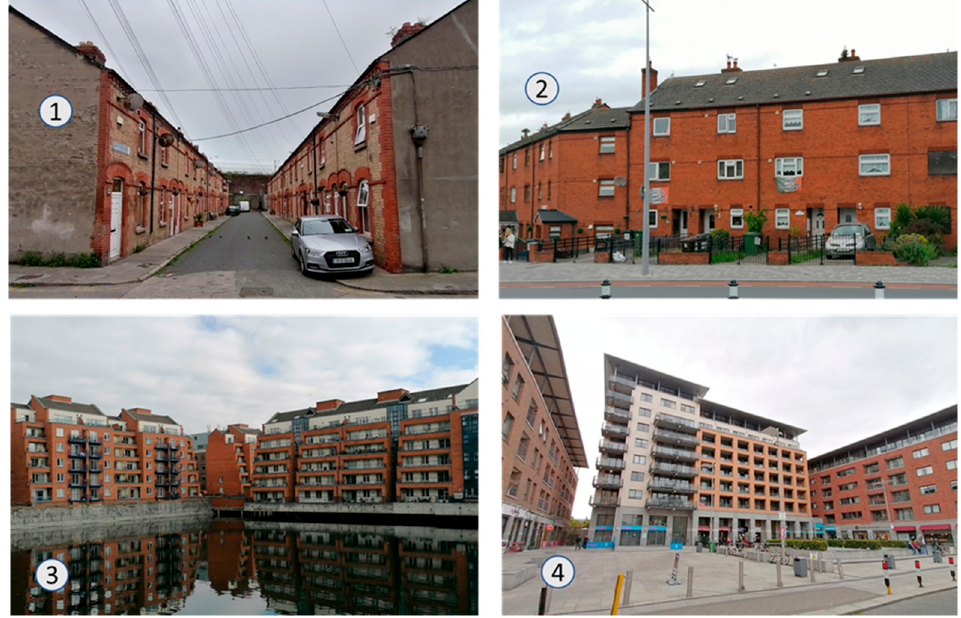
Figure 2. Residential building types in the study area: single family homes constructed in terraced layout prior to 1980 ( 1 ) and between 1980 and 2000 ( 2 ), and apartment blocks constructed in the 1990s ( 3 ) and after 2000 ( 4 ).